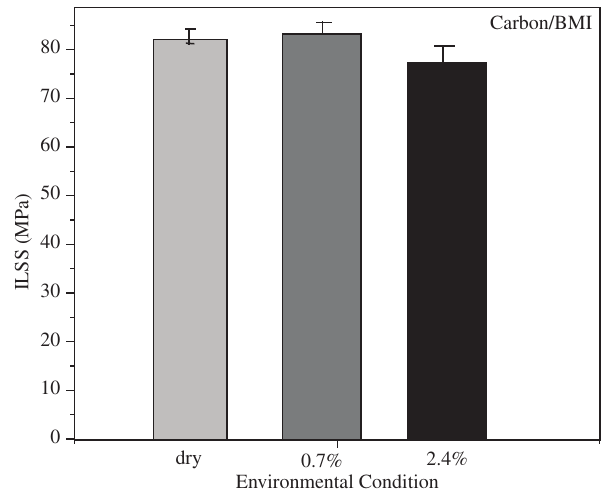
Figure 3. Variation of interlaminar shear strength as function of environmental conditioning of carbon fabric/epoxy